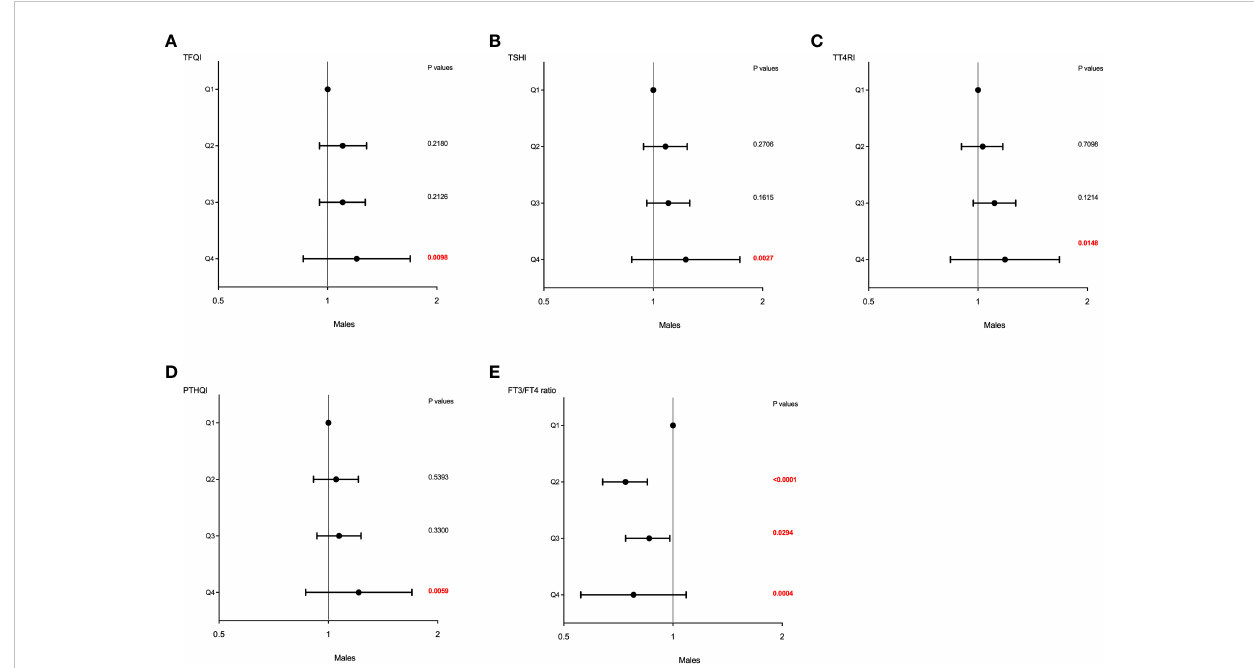
FIGURE 3 The forest maps of logistic regression analysis for the association between HUA and thyroid hormone sensitivity in men. (A) The ORs for HUA across TFQI quartiles. (B) The ORs for HUA across TSHI quartiles. (C) The ORs for HUA across TT4RI quartiles. (D) The ORs for HUA across PTHQI quartiles. (E) The ORs for HUA across FT3/FT4 ratio quartiles. Model was adjusted for age, BMI, dyslipidemia, diabetes, fatty liver, and hypertension. Q1, the fi rst quartile, Q2, the second quartile, Q3, the third quartile, Q4, the fourth